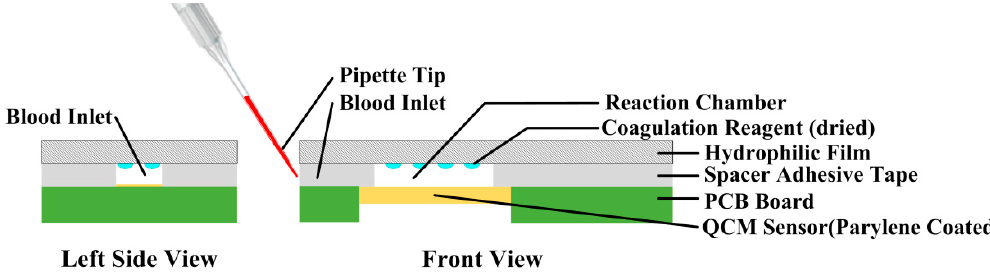
Figure 9. The structure of the further developed coagulation test chip to reduce the sample volume.